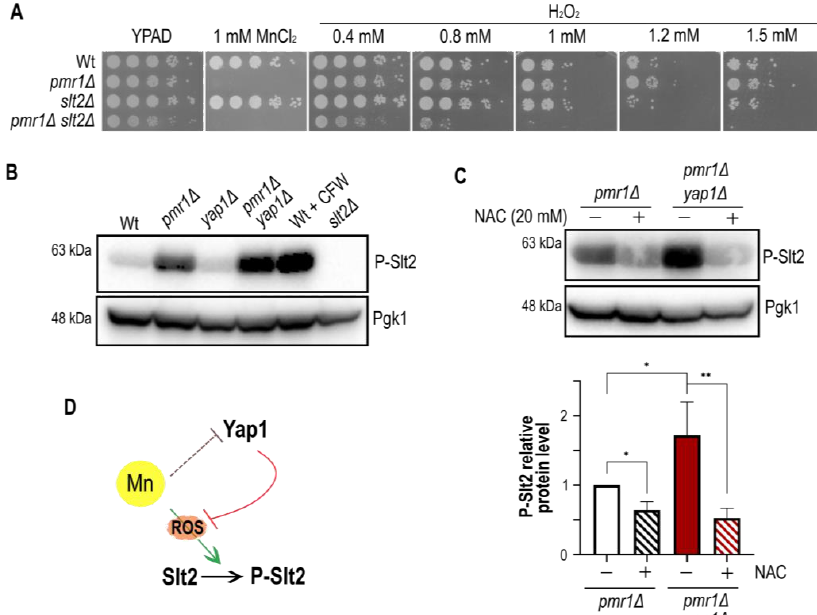
Figure 6. Slt2 has a dual role in ROS and manganese stress defense. ( A ) The growth of 10-fold dilutions of exponentially growing cells is shown. Strains, MnCl 2 and H 2 O 2 concentrations are indicated. Pictures were taken after 2 days of growth. ( B ) Comparison of Slt2 phosphorylation levels in cells lacking Pmr1 and/or Yap1. Wt cells treated with calcofluor white (CFW) and slt2 ∆ mutants were used as positive and negative controls, respectively. ( C ) Comparison of Slt2 phosphorylation levels in N-acetyl cystein (NAC) treated cells. The quantification of Slt2 phosphorylation is shown (bottom). SD (with bars) and p-value are indicated ( p -value 0.05 *; 0.01 **). The value obtained for untreated pmr1∆ mutants was set as 1. ( D ) Model for manganese stress-induced Slt2 activation and Yap1 protein decay, respectively. See text for details.